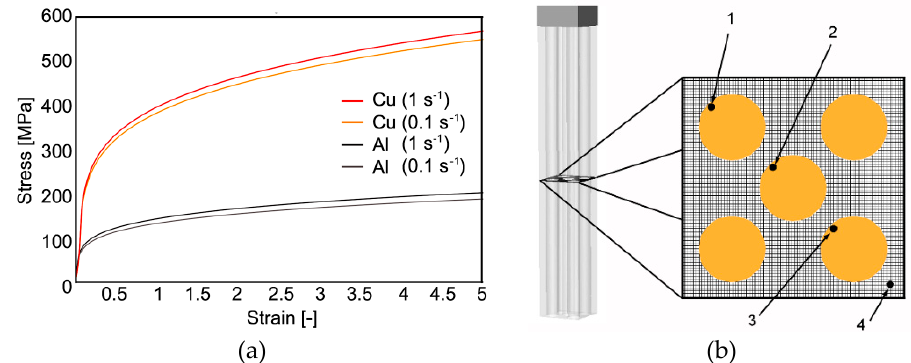
Figure 2. Stress-strain curves used for FEM (finite element method) computations ( a ); placement of analyzed sections within extruded composite ( b ).